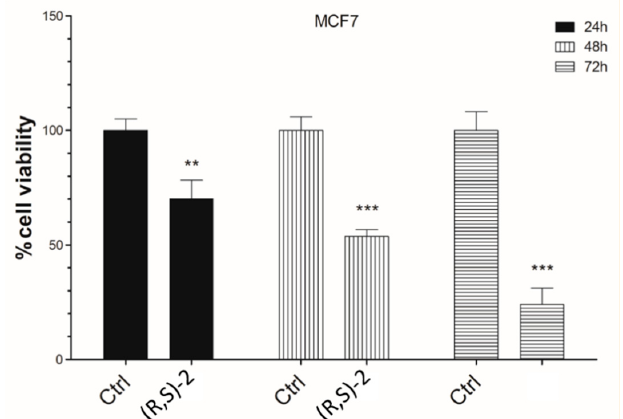
Figure 2. E ff ects of racemic mixture (R,S)-2 on MCF-7 cell viability. In total, 10 4 cells were seeded in triplicate in 96-well plates and treated with (R,S)-2 at concentration of 10 µ M, cells treated with DMSO were used as control. Cell viability was measured by an MTT assay at 24, 48, and 72 h after treatment. Results are expressed as a percentage of control, analyzed by ANOVA (** p < 0.005; *** p < 0.0005), each column represents the mean ± SD of three di ff erent